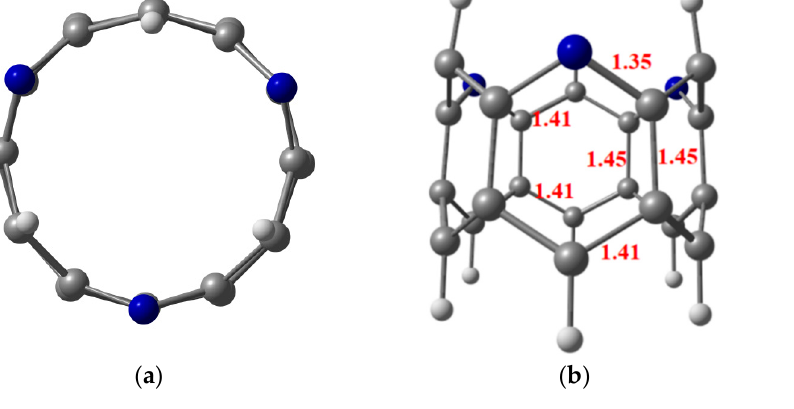
Figure 1. Top view ( a ) and side view ( b ) of the optimized structure of nanobelt at ω B97XD/6- 311G(d,p) level of theory, where ( c ) presents the possible sites for doping transition metal atom; benzene ring (A), pyridine ring (B) and C—C bridge (C). Grey, whitish, and blue balls represent carbon, hydrogen, and nitrogen atoms, respectively.